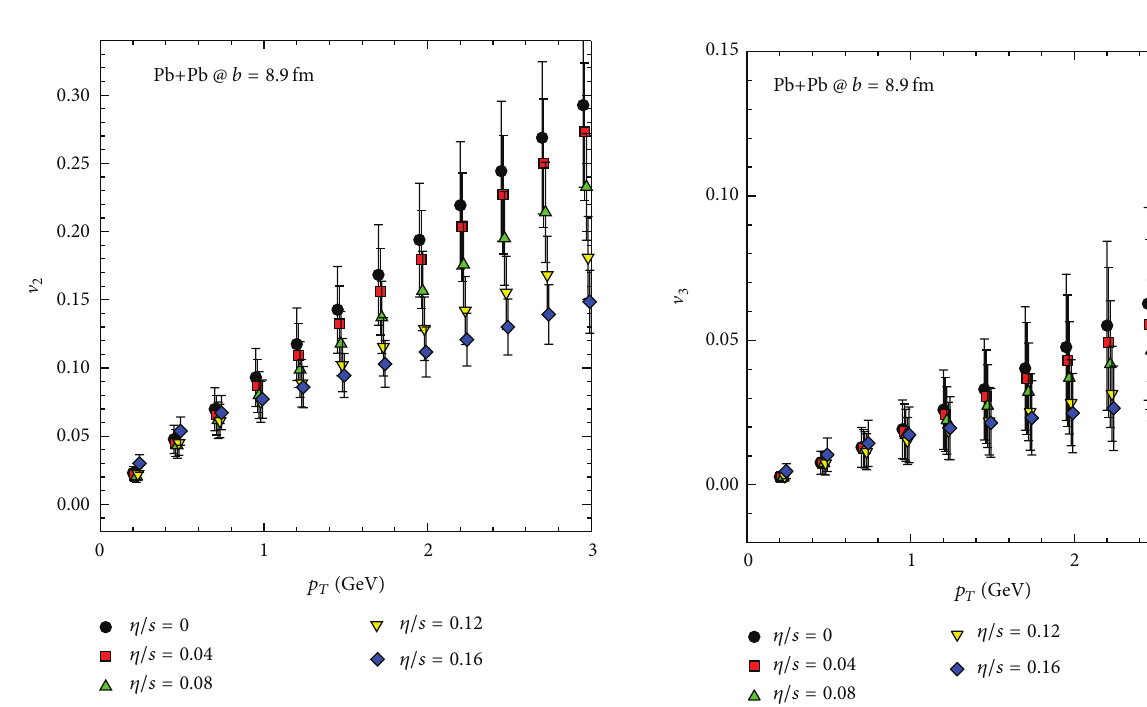
Figure 21: Same as in Figure 20 but for triangular flow. The figures are from